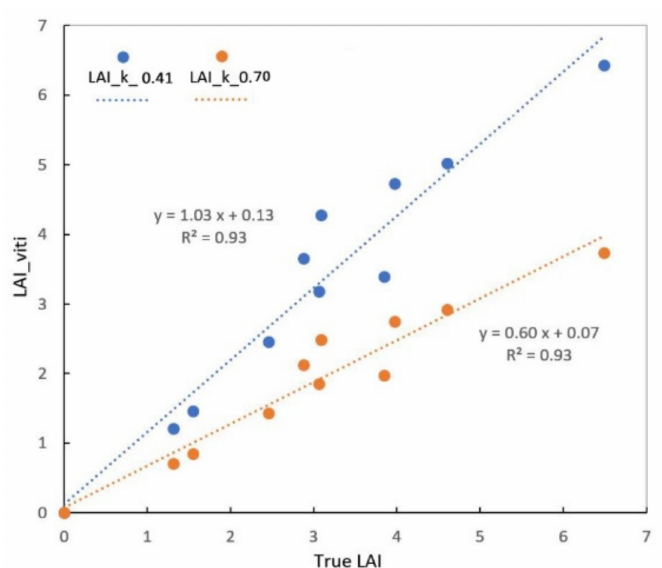
Figure 6. The relationship between true and VitiCanopy calculated LAI (LAI_viti) values before and after optimization of k value. The default and optimized k values were 0.70 and 0.41